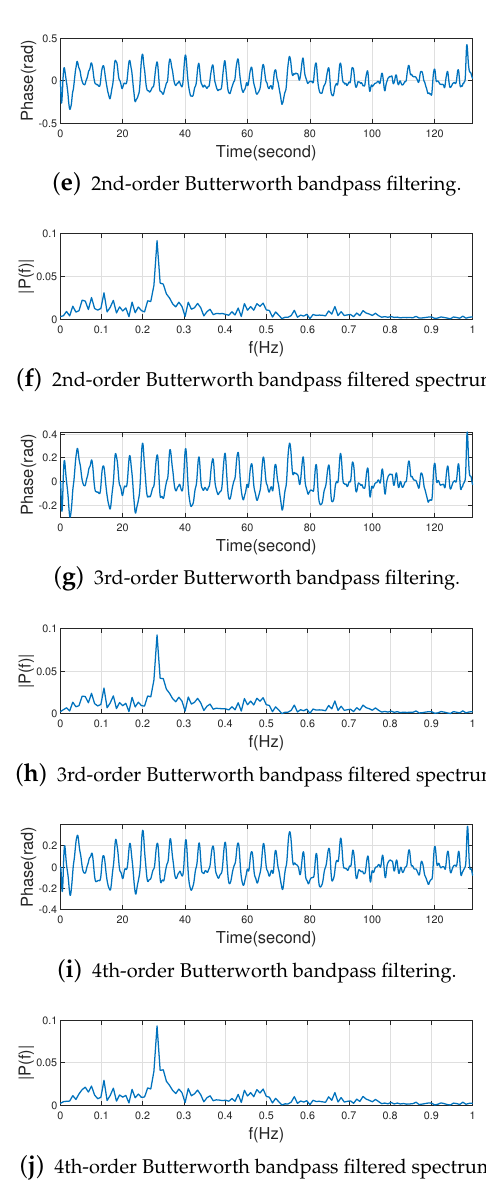
Figure 10. Raw data with 1st to 4th order Butterworth bandpass filtering and corresponding spectrum. It can be seen from Figure 10 that the 2nd-order Butterworth bandpass filter has been able to reduce the low-frequency noise in the respiratory signal well and highlight the respiratory rate. Starting from the 5th-order Butterworth bandpass filter, the filtered data will be distorted. In summary, if the order of the Butterworth bandpass filter is too high, the data will be distorted. For the Butterworth filter, the frequency response curve in the passband is maximally flat and ripple-free, while it decreases to zero in the stopband [39]. Moreover, the higher the order of the Butterworth filter, the faster the decay of the frequency response curve in the stopband. As can be seen from the Figure 10d,f,h,j, the frequency response of the respiratory signal within 0 to 0.1 Hz (the cut-off frequency) becomes smaller and smaller as the order of the Butterworth bandpass filter increases. We found in our experiments that the second-order Butterworth bandpass filter can already eliminate the low-frequency noise well enough compared to the first-order Butterworth bandpass filter as can be seen from Figure 10d,f. At this point, increasing the order of the Butterworth bandpass filter again will not result in a significant improvement as shown in Figure